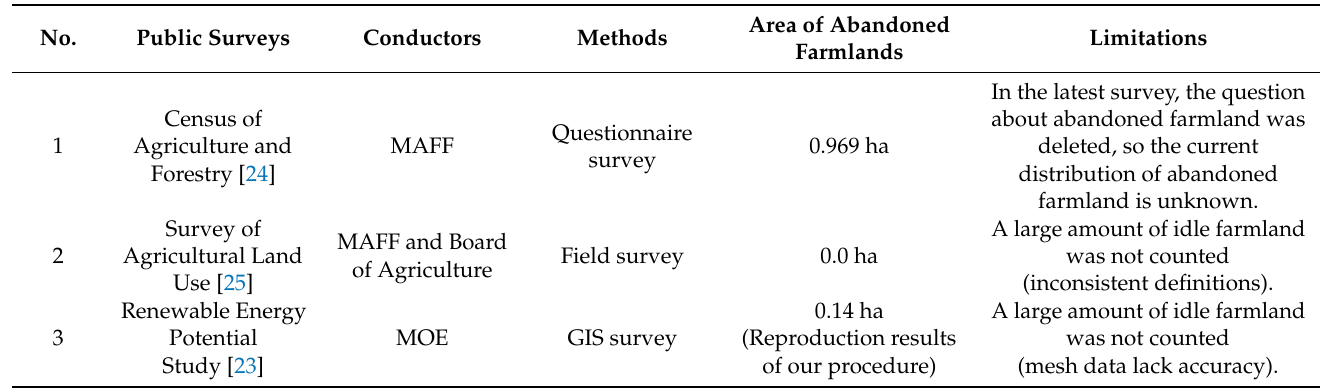
Table 2. Japanese public surveys of abandoned farmland.